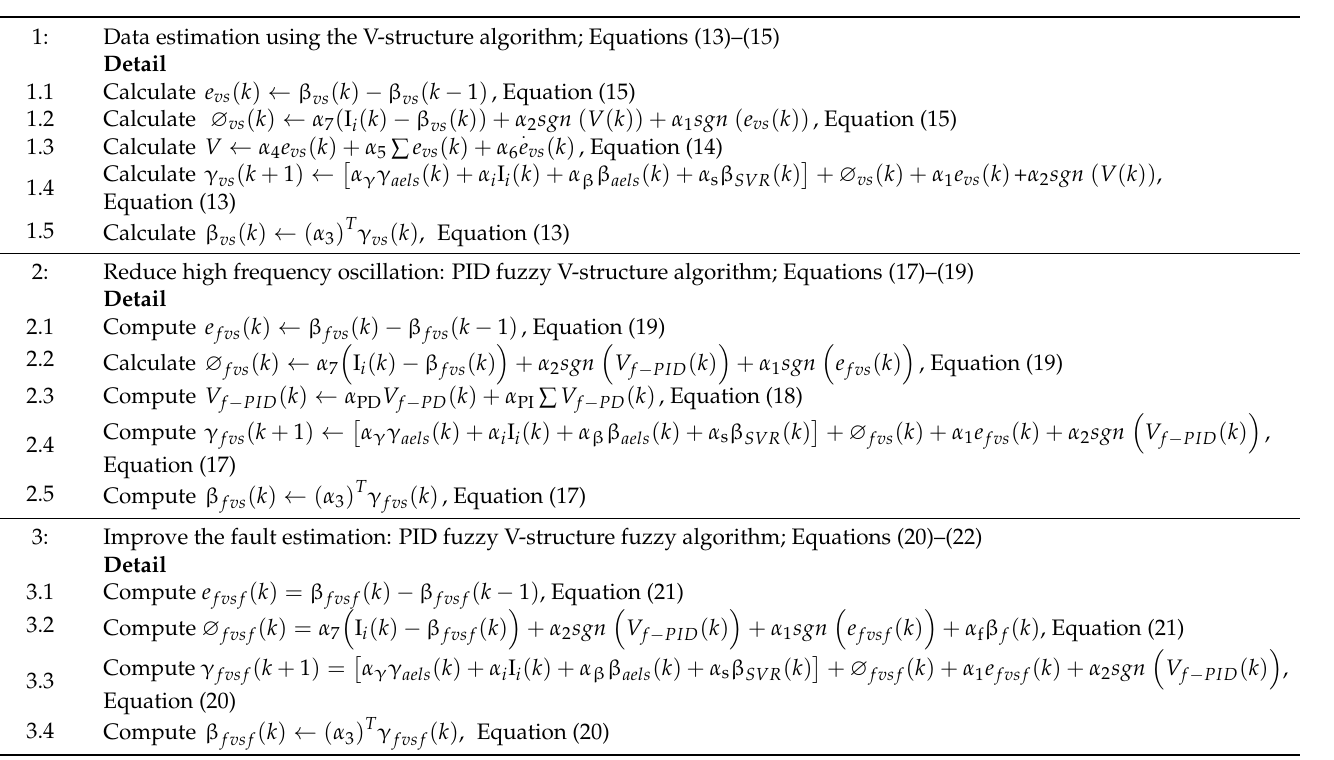
Table 3. Proposed hybrid data estimation using the fuzzy V-structure fuzzy fault